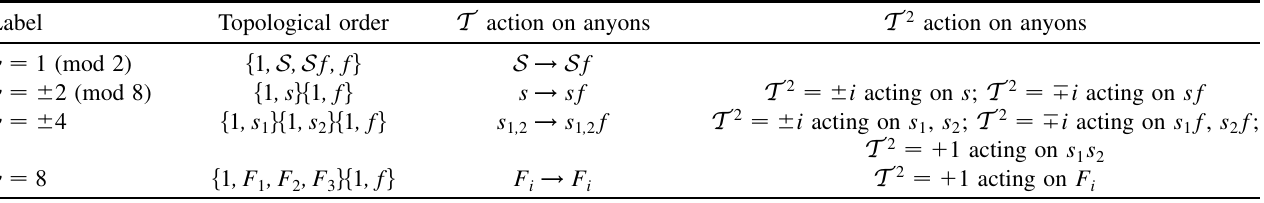
TABLE I. Summary of surface topological orders of TScs: The first row is the non-Abelian SO ð 3 Þ to the odd (cid:1) TSc , where S represents the non-Abelian excitation with semionic topological spin. The second row is the Abelian semion-fermion theory that we have argued is related to the (cid:1) ¼ (cid:2) 2 TSc . The third row contains two copies of the semion-fermion theory. Finally, the last row shows four copies of the semion-fermion theory, which corresponds (modulo the electron) to the three- fermion topological order that is also the surface topological order of a purely bosonic topological phase with a Z eight copies of the semion-fermion topological order are trivial, i.e., realizable in a purely two-dimensional system with T , which implies that interactions unravel the (cid:1) ¼ 16 TSc connecting it to the trivial phase, consistent with Ref. [32]. The fermion f transforms as T 2 ¼ (cid:1) 1